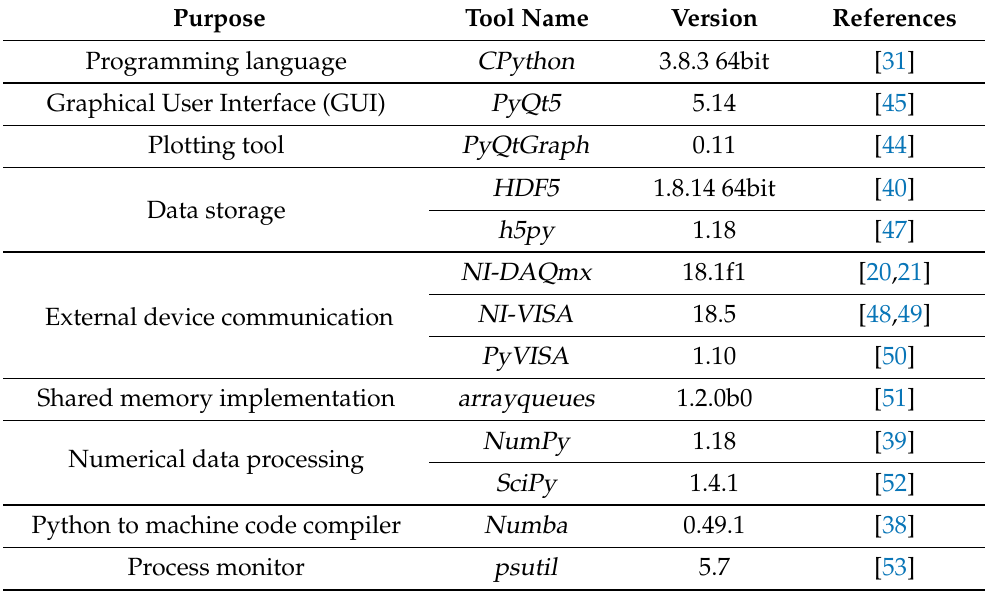
Table 1. List of software